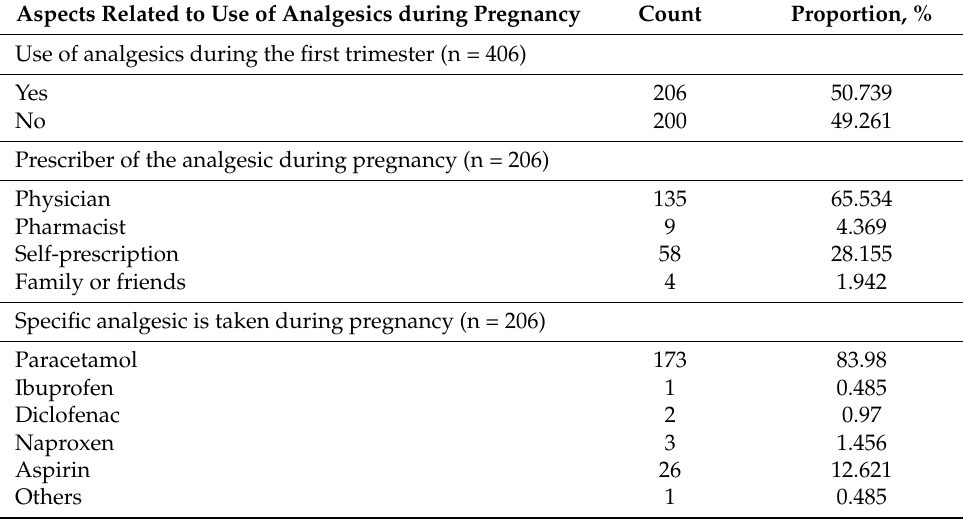
Table 2. Use of analgesics before and during